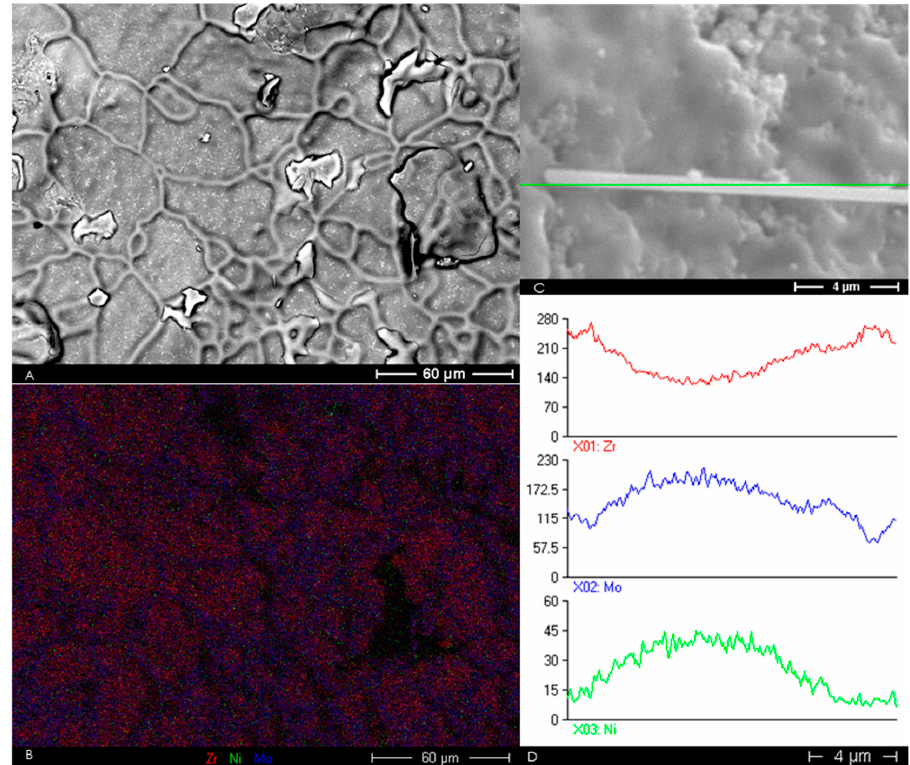
Figure 5. ( A ) 10 mol.% MoO 2 Ni(NO 3 ) 2 infiltrated 8YSZ (BEI). ( B ) EDS map of region shown in